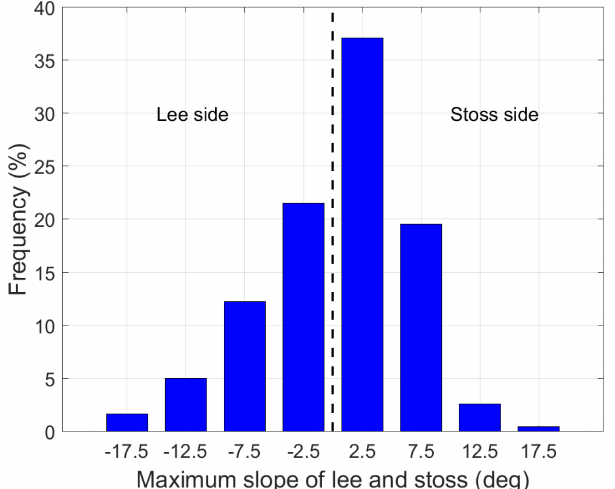
Figure 16. Maximum slopes (in degrees), representing megaripple structures, in two typical examples in Brown Bank area.